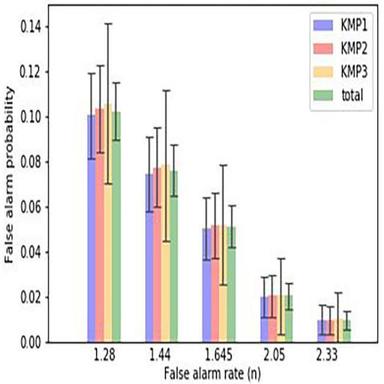
3. The desired false alarm probabilities matched well with the simulation results. The false alarm probability was calculated by dividing the number of raised alarms by the total number of ID calculation during operation. In addition to counting the total alarms, alarms raised at each KMP were monitored. The detailed numerical data is shown in